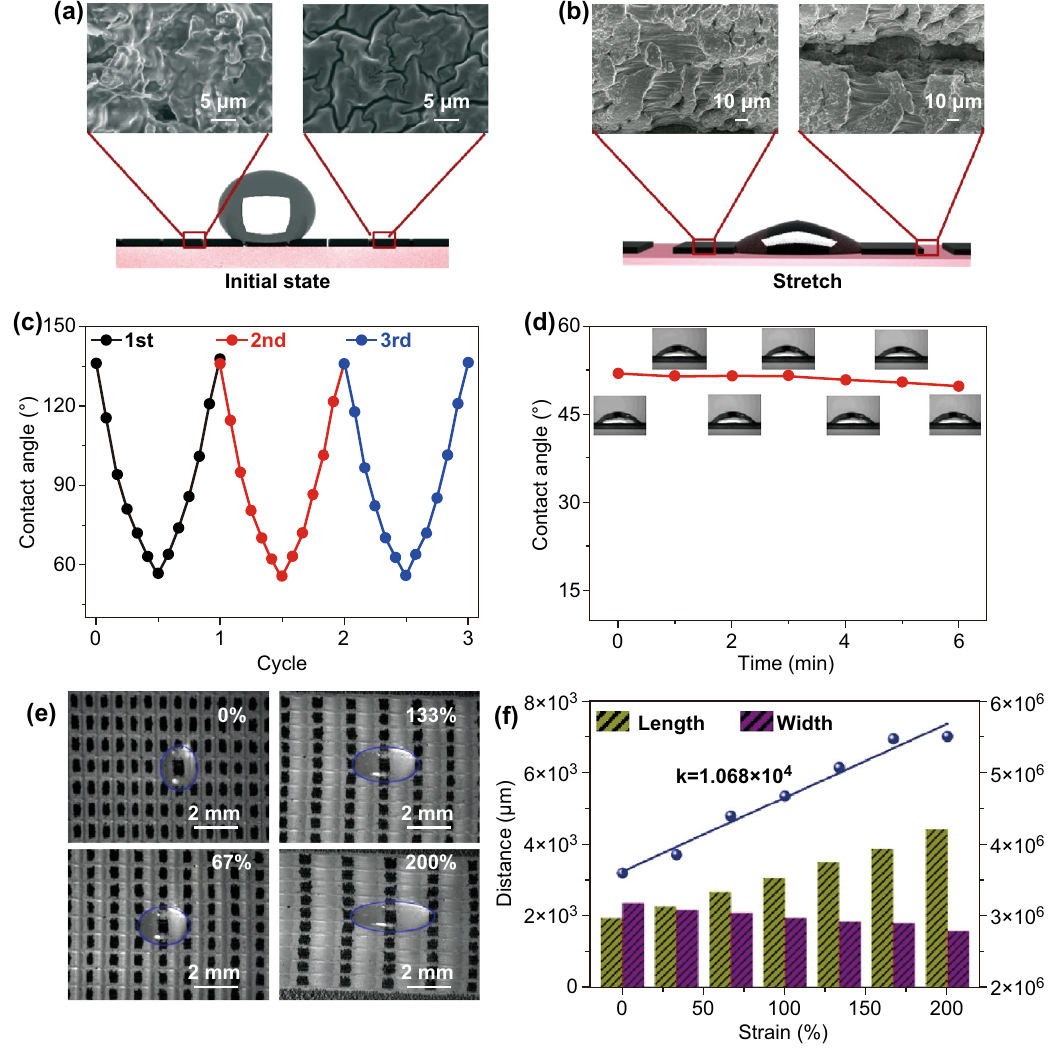
Fig. 3 a , b SEM images of the arrays and interspace between on the film and the schematic diagrams of the composite film at the initial state and stretching state, along with the corresponding water contact angles and optical photographs. c , d Cycle performance stability performance of the composite film with arrays of 10 × 15. e Photographs of the stretched water drop from the top view at different strains. f The distance–strain and area–strain curves of the composite